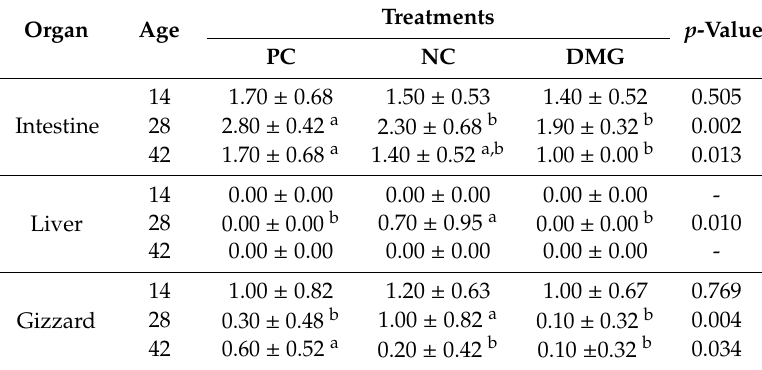
Table 4. Mean grade of lesion scores in the intestine, liver and gizzard in each experimental group. Organ Age